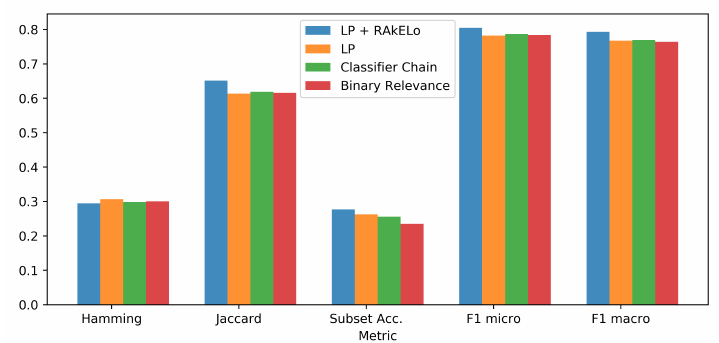
Figure 2: Comparison of averaged evaluation results for all transformation